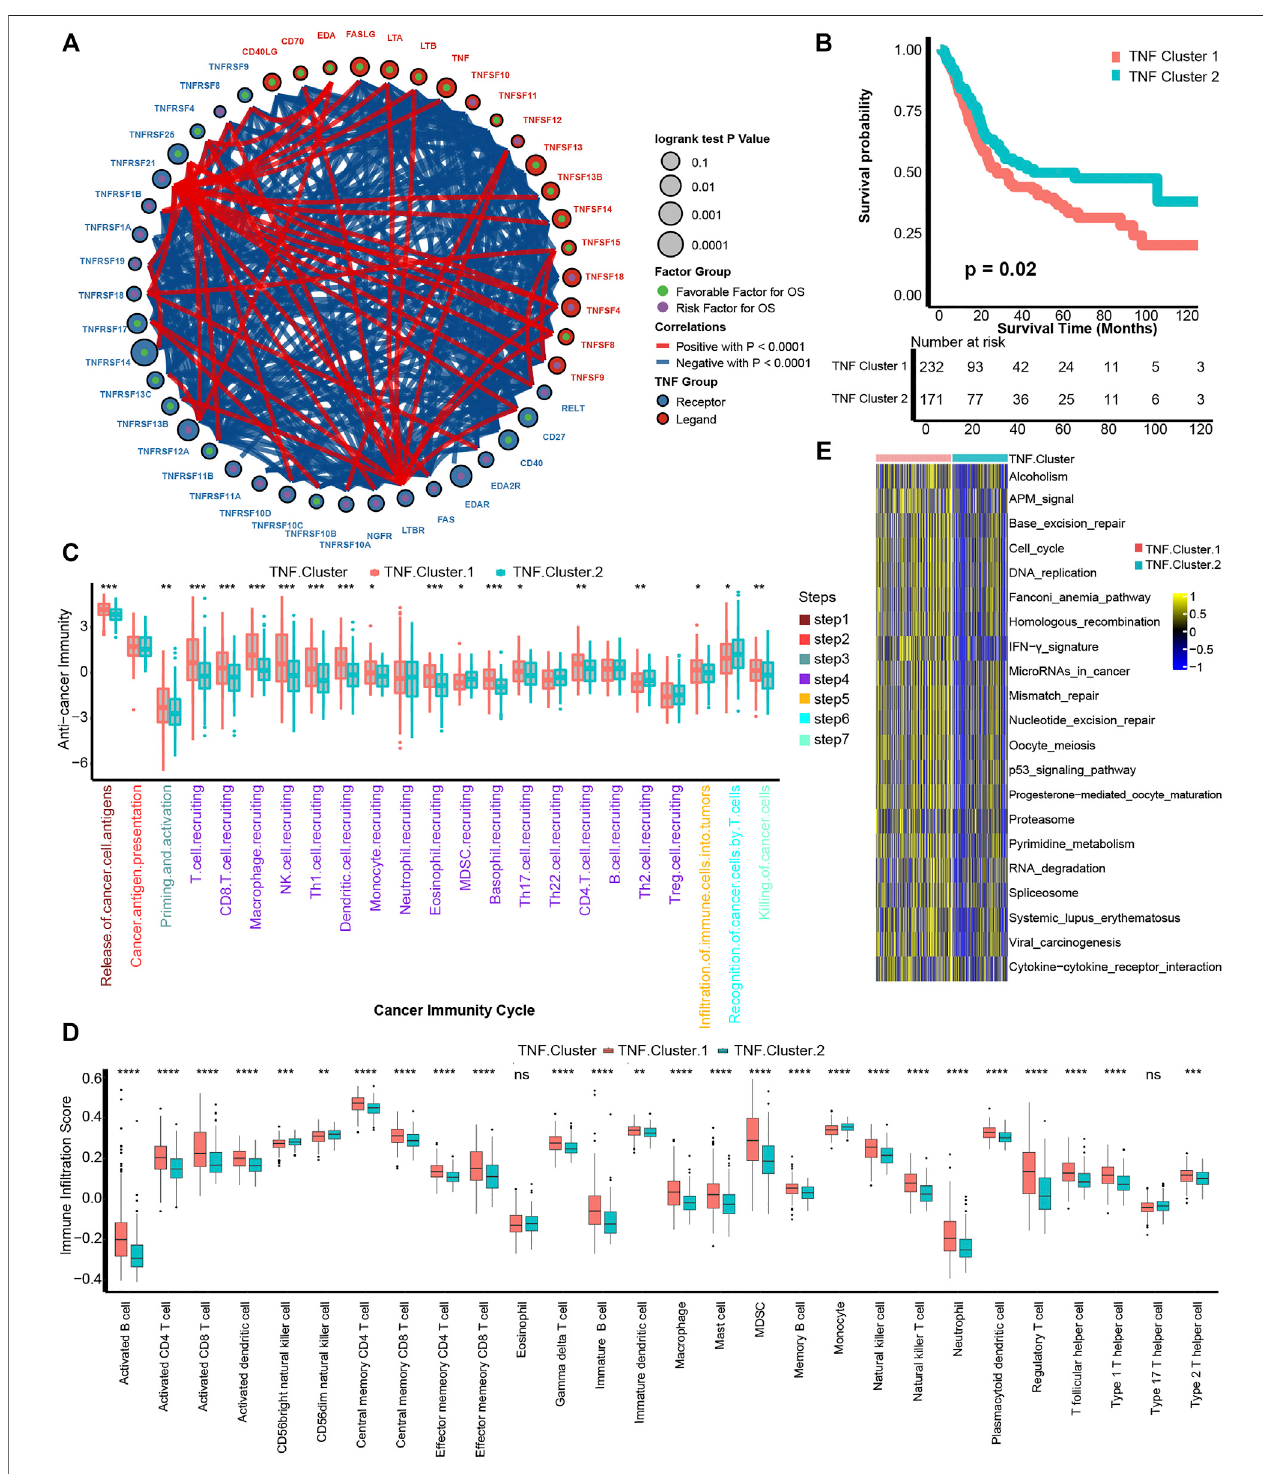
FIGURE 1 | Development of TNF-based patterns and association with TIME. (A) The interaction between TNF family members in bladder carcinomas. The size of the circle represents the p value for overall survival (OS) calculated using log-rank test. The green and purple dots in the circle represent the favorable and risk factors for OS,respectively;redandbluelinesrepresentpositiveandnegativecorrelationsbetweenTNFfamilymembers,respectively. (B) K-MplotofOSbetweentwoTNF-based patterns;redandazurelinesrepresentTNFclusters1and2,respectively. (C) ThedifferentlevelsofanticancerimmunitybetweentwoTNF-basedpatterns;redand azurelinesrepresentTNFcluster1and2,respectively. (D) Thedifferentin fi ltrationlevelsof28immunecellsintheTMEusingssGSEAalgorithmbetweentwoTNF-based patterns;redandazurelinesrepresentTNFclusters1and2,respectively. (E) ThedifferentactivatedlevelsofgenesignaturesassociatedwithICBresponsebetweentwo TNF-basedpatterns.RedandazurelinesrepresentTNFclusters1and2,respectively.* p < 0.05,** p < 0.01,*** p < 0.001,**** p < 0.0001;ns,notstatisticallysigni fi cant.